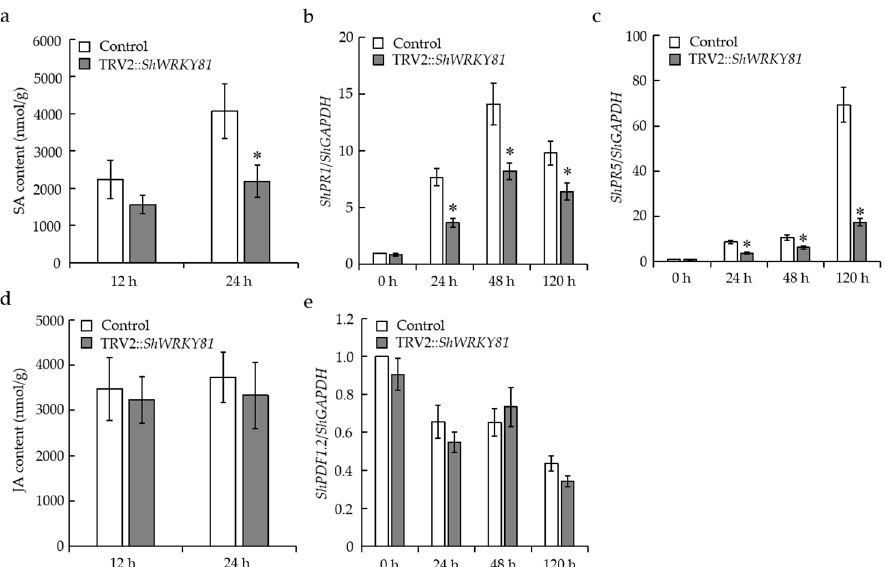
Figure 8. Accumulation of phytohormones and induction of phytohormone-inducible defense genes in ShWRKY81 -silenced LA1777 seedlings by On -Lz. The levels of SA ( a ) and JA ( d ) in control and ShWRKY81 -silenced plants at 12 and 24 hpi. The transcripts of ShPR1 ( b ), ShPR5 ( c ), and ShPDF1.2 ( e ) in control and ShWRKY81 -silenced plants at the time points indicated upon On -Lz infection. Values are shown as the means ± standard error of three biological replicates, and statistically significant difference are represented by asterisks (Student’s t -test, *, p < 0.05).